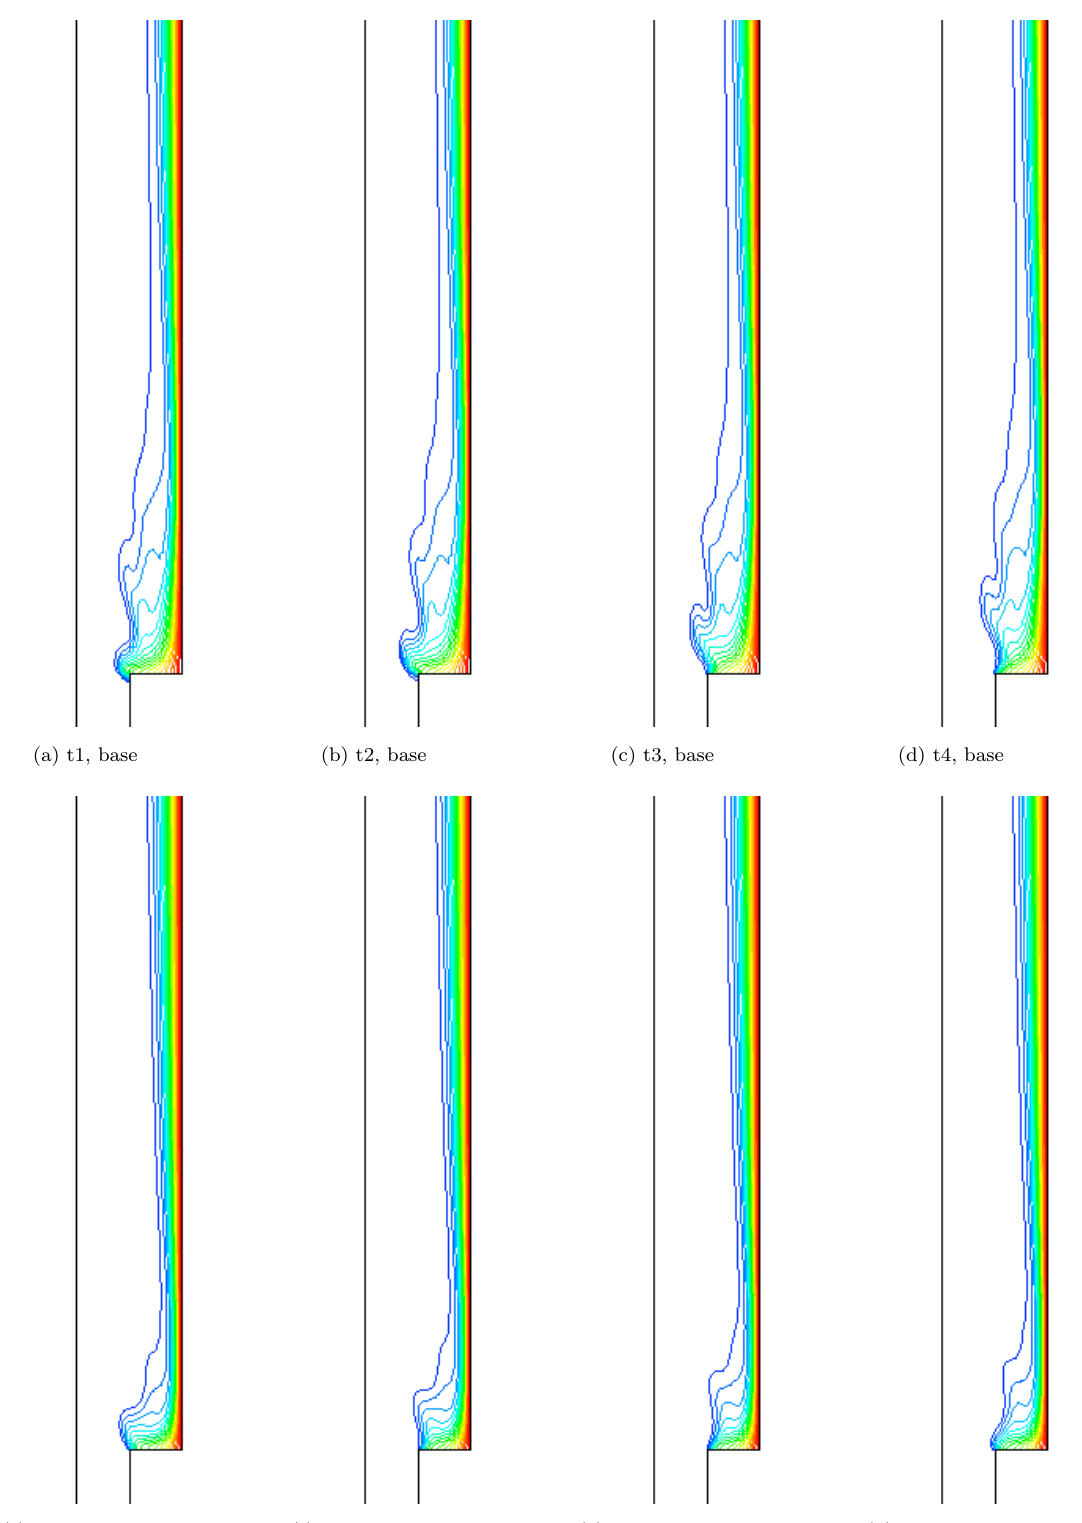
Figure 5: wall moves in negative x direction: Effects of varying Richardson number on the templines and isotherms for fixed values of (Ra I = 10 6 , E=1000, s l = 0 . 5 L ϕ = 0 . 02) Figure 7. Isotherm distributions for several time instances within a period for the base fluid and for the nanofluid with cylindrical